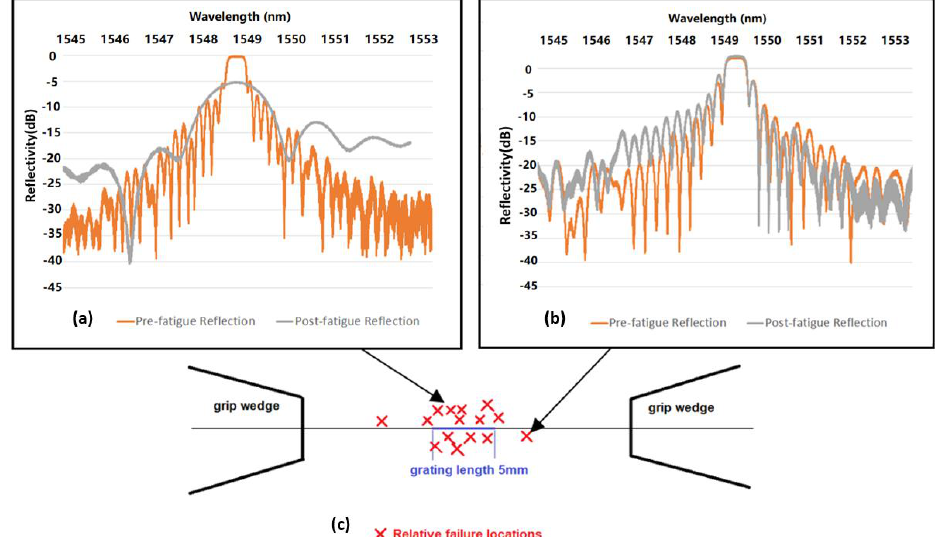
Figure 5. ( a ) Reflectivity spectra comparison of a Type II grating before and after it failed in the grating region. ( b ) Reflectivity spectra comparison of a Type II grating before and after it failed outside of the grating region. ( c ) Fibre fracture location schematic showing that Type II FBGs predominantly fracture in the grating region.